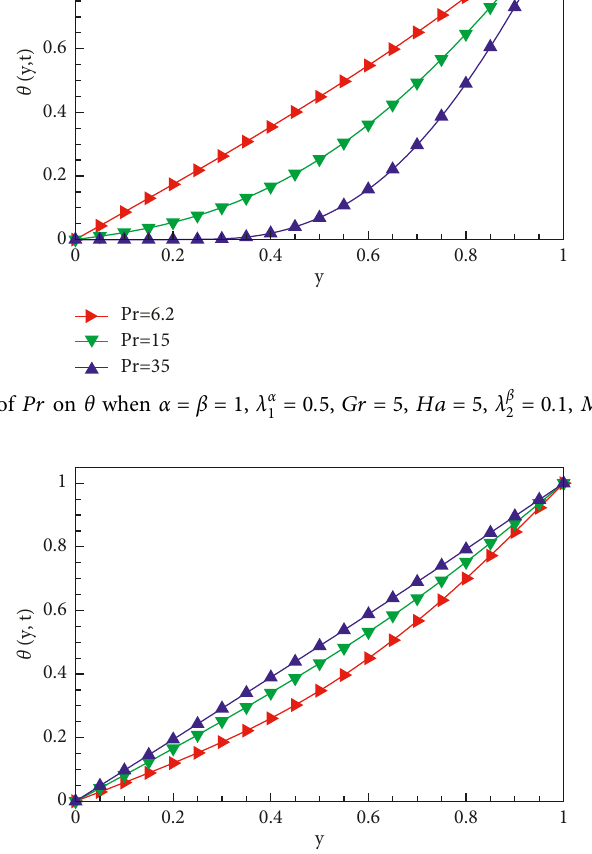
� 0 . 5 , Gr � 5 , Ha � 5 , λ β 1